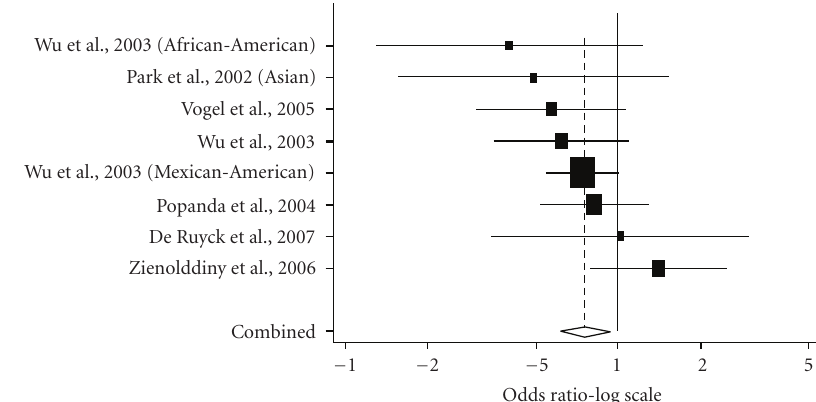
Figure 1: Meta-analysis of 8 studies (5 Caucasian studies and 3 non-Caucasian studies) of lung cancer and the XPA G23A polymorphism (GG versus AA). The center of a box and the horizontal line (logarithm) indicate the odds ratio (OR) and the 95% confidence interval (CI) in each study, with the areas of the boxes representing the weight of each study. The summary OR based on random e ff ects model is represented by the middle of a diamond whose width indicated the 95% CI. The summary OR is shown by the dotted vertical line. Statistical heterogeneity between studies was assessed with Cochran Q test ( Q = 7.86, P = . 35). Summary: OR = 0 . 76 (95% CI = 0.61–0.94).